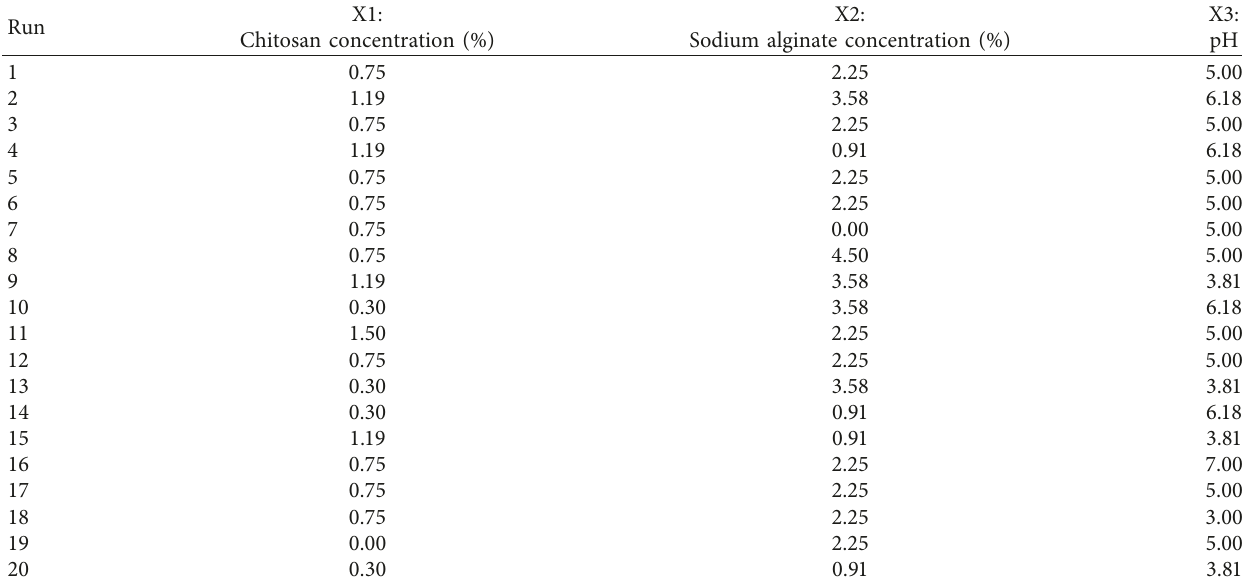
Table 2: Central composite experimental design for the three independent variables used in this study.